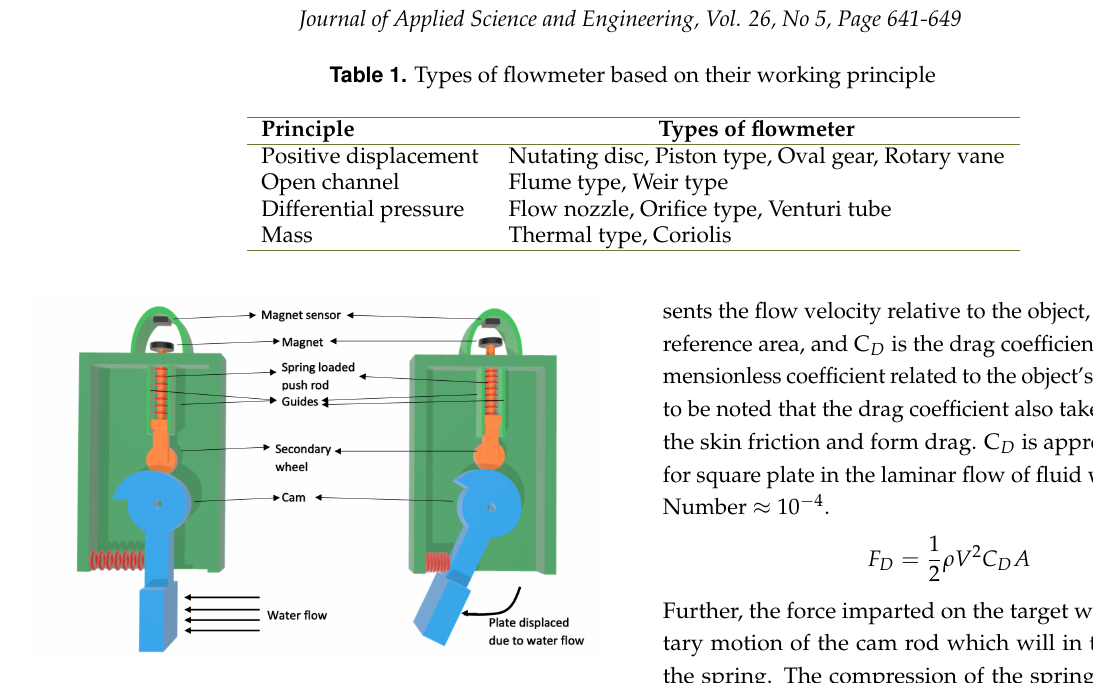
Fig. 1. Schematics of the developed Flow rate Measurement Sensor